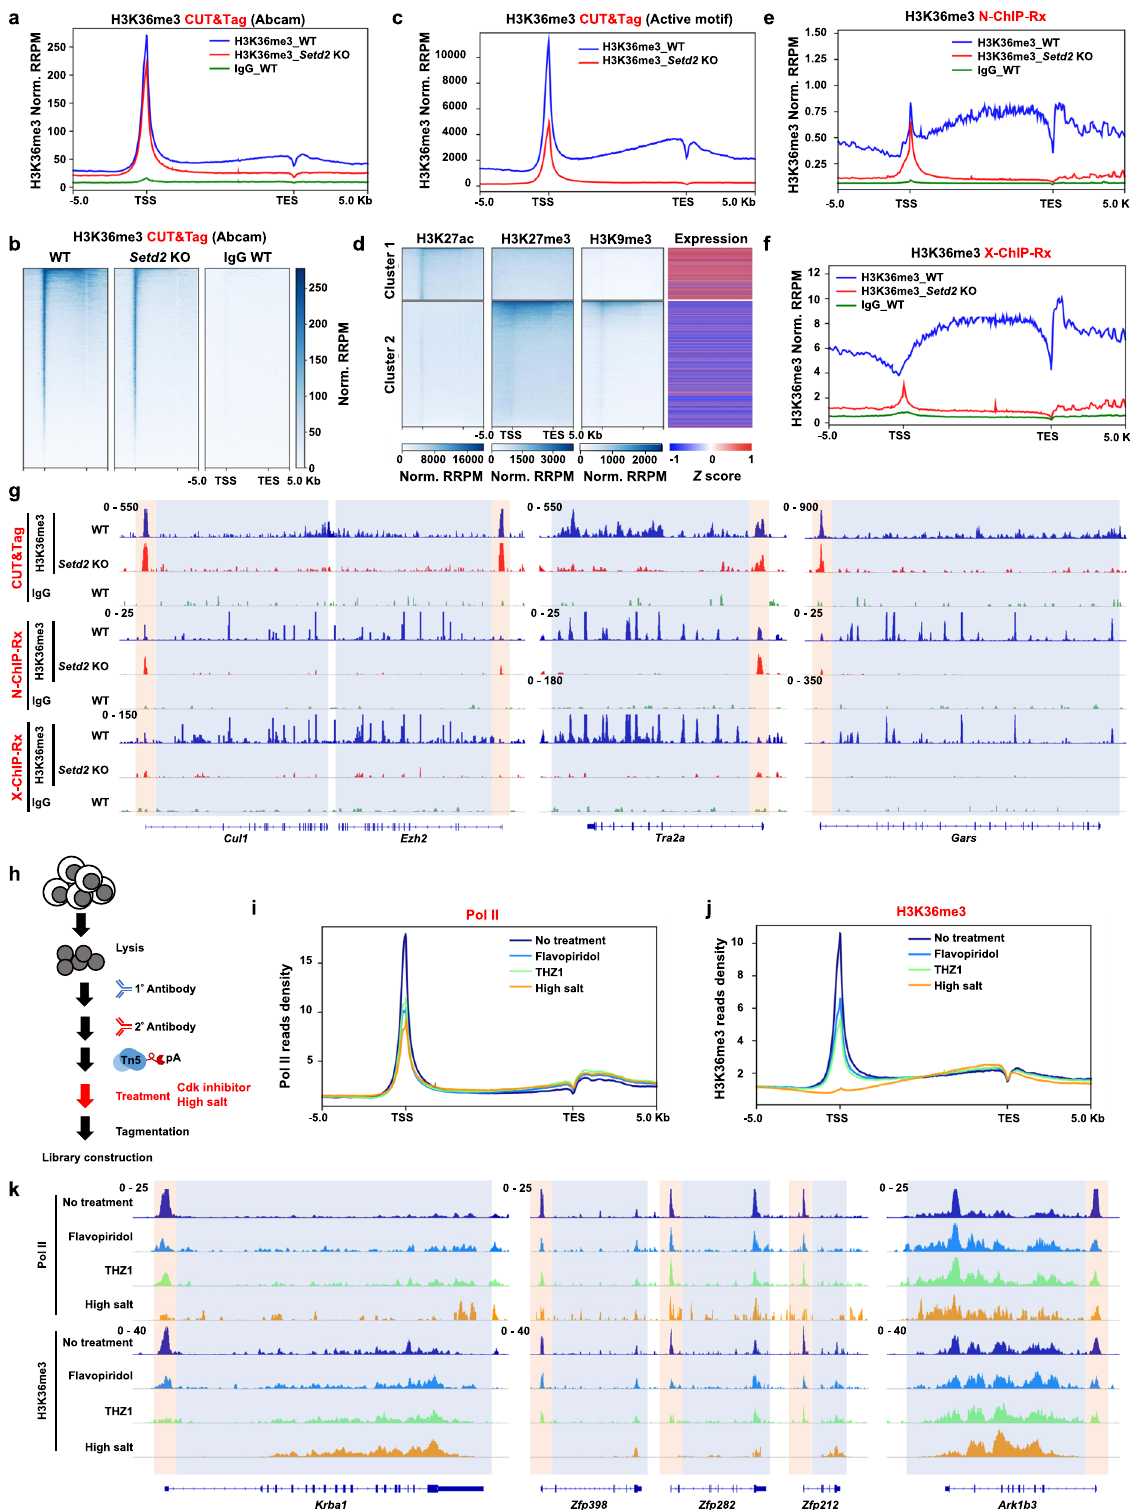
the promoters of weakly expressed genes, and H3K27ac was found at the promoters of genes with high expression levels (Fig. 1d). More importantly, H3K27me3 and H3K9me3 CUT&- Tag signals were not enriched at the active gene promoters, which were in an open state for transposome access, suggesting that the Tn5 transposome was not randomly targeted to open chromatin regions in the CUT&Tag